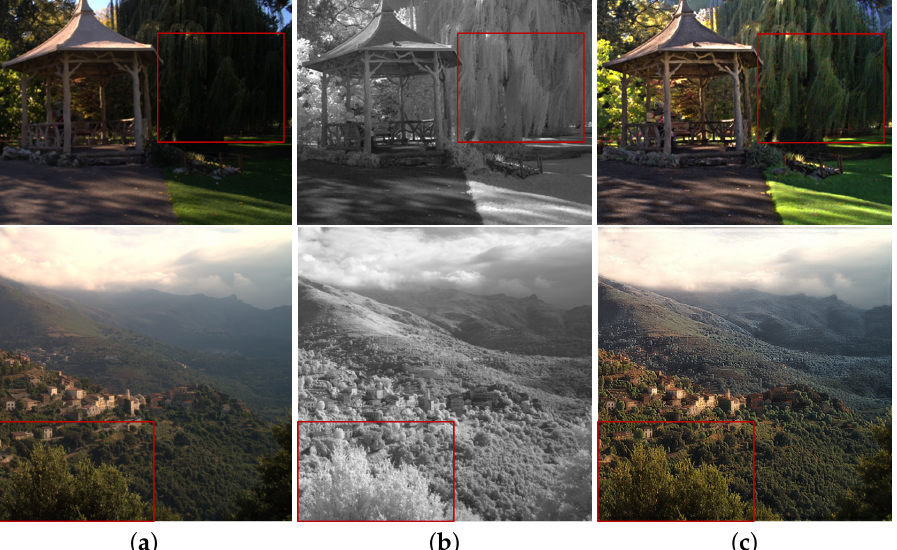
Figure 18. Experimental results for the paired images under normal illumination conditions. ( a ) RGB images; ( b ) NIR images; ( c ) Fusion